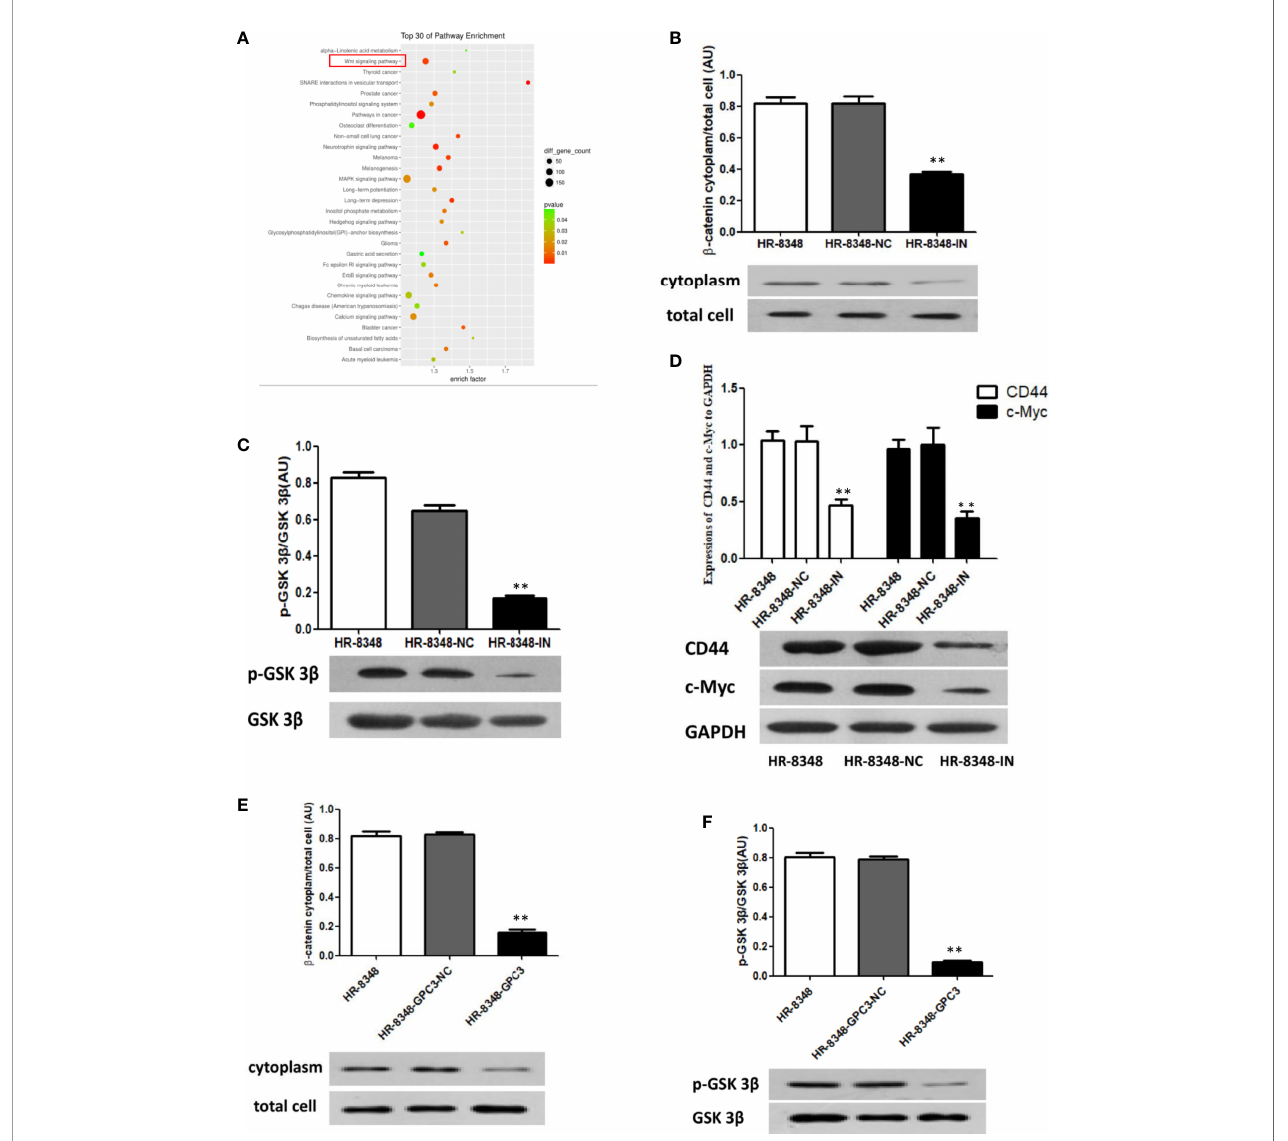
FIGURE 8 | Effect of miRNA-96-5p on the status of Wnt/ b -catenin signal transduction pathway in rectal cancer cells. (A) Screening of enriched signal pathway indicated that Wnt signal pathway was one of the important factors affecting irradiation resistance of rectal cancer. (B, C) Down-regulation of miRNA-96-5p signi fi cantly reduced the expression of b -catenin in the cytoplasm and the phosphorylation level of GSK3 b in rectal cancer cells. (D) After the down-regulation of miRNA-96-5p, the expression of CD44 and c-Myc was signi fi cantly reduced in rectal cancer cells. (E, F) GPC3 over-expression signi fi cantly reduced the expression of b -catenin in the cytoplasm and the phosphorylation level of GSK3 b in rectal cancer cells. **P <